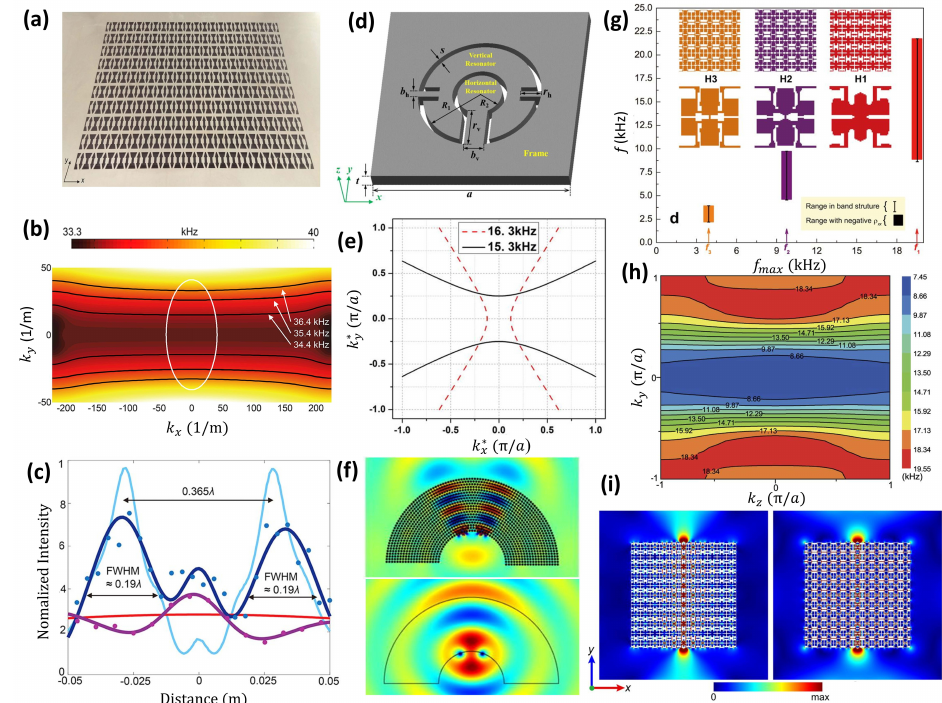
Figure 7. ( a ) Fabricated hyperbolic EMTM lens; ( b ) EFC of hyperbolic EMTM lens. White contour: equi-frequency contour of the isotropic aluminum plate at 35.48 kHz; ( c ) Intensity profiles obtained by simulation with EMTM (cyan line), without EMTM (red line) and by experiment with EMTM (blue dot) and without EMTM (purple dot). Gaussian regression was applied for experiment data (blue and purple line); ( d ) Unit cell design of EMTM; ( e ) EFC of EMTM calculated at 15.3 kHz and 16.3 kHz; ( f ) Divergence of the displacement fields with hyperlens (upper). Divergence of the displacement fields without hyperlens (lower); ( g ) Microstructures for different target frequencies (H1 at 19.5 kHz, H2 at 9.75 kHz and H3 at 3.904 kHz); ( h ) EFC of the third band for H3; ( i ) Wave propagations in H1 at 13 kHz (left) and H3 at 2.3kHz (right). The measured resolutions are 0.169 λ (left) and 0.02 λ (right). ( a – c ) adapted from [93]. ( d – f ) adapted from [94]. ( g – i ) adapted from